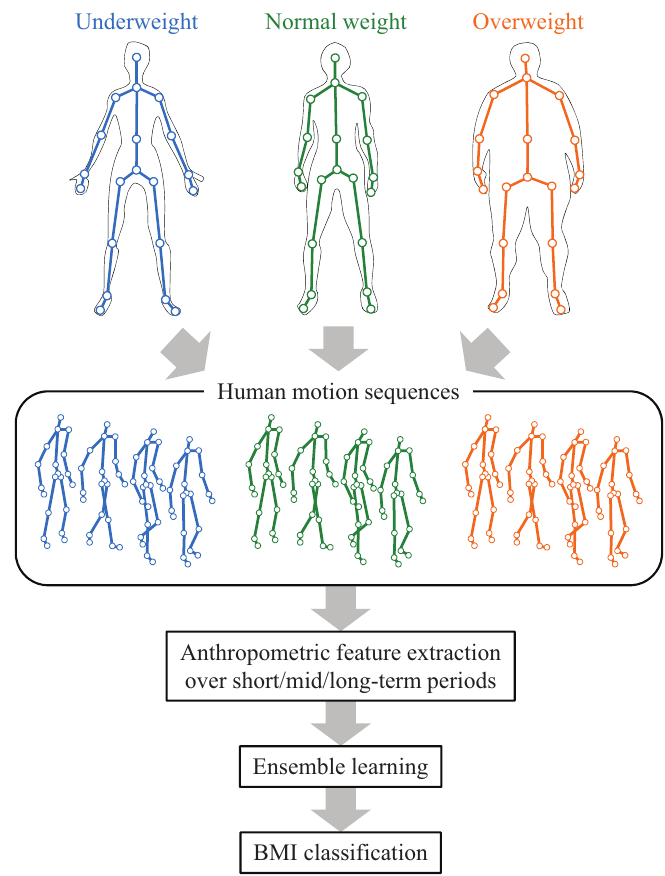
Figure 1. Block diagram for classifying the body mass index (BMI) from 3D human motion